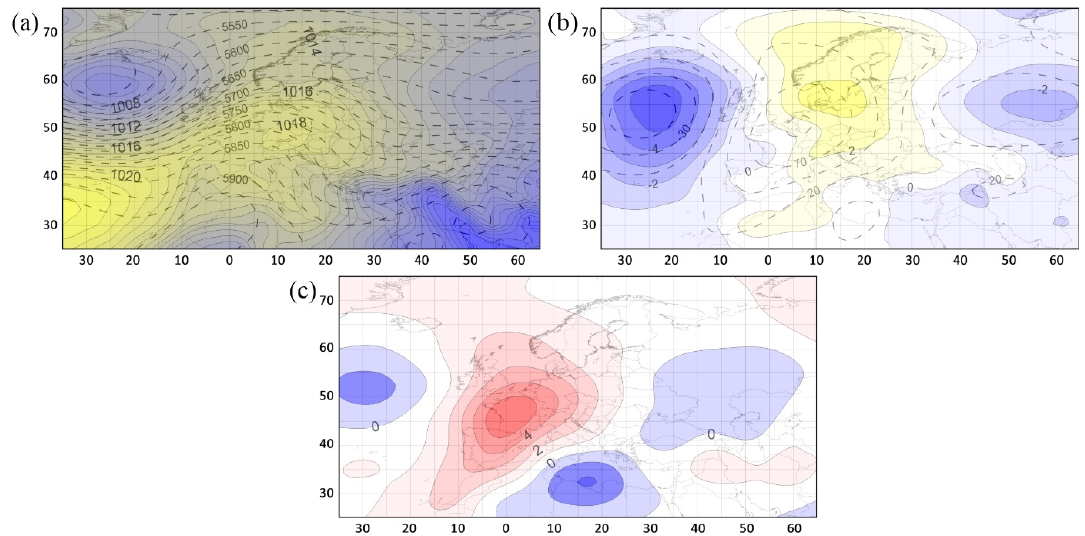
Figure 7. Composites of SLP in hPa (colour scale) and z500 hPa in gpm (dashed lines) ( a ); anomalies of SLP in hPa (colour scale) and z500 hPa in m (dashed lines) ( b ); anomalies of T850 in °C ( c ) for the synoptic type 1 causing HWs.